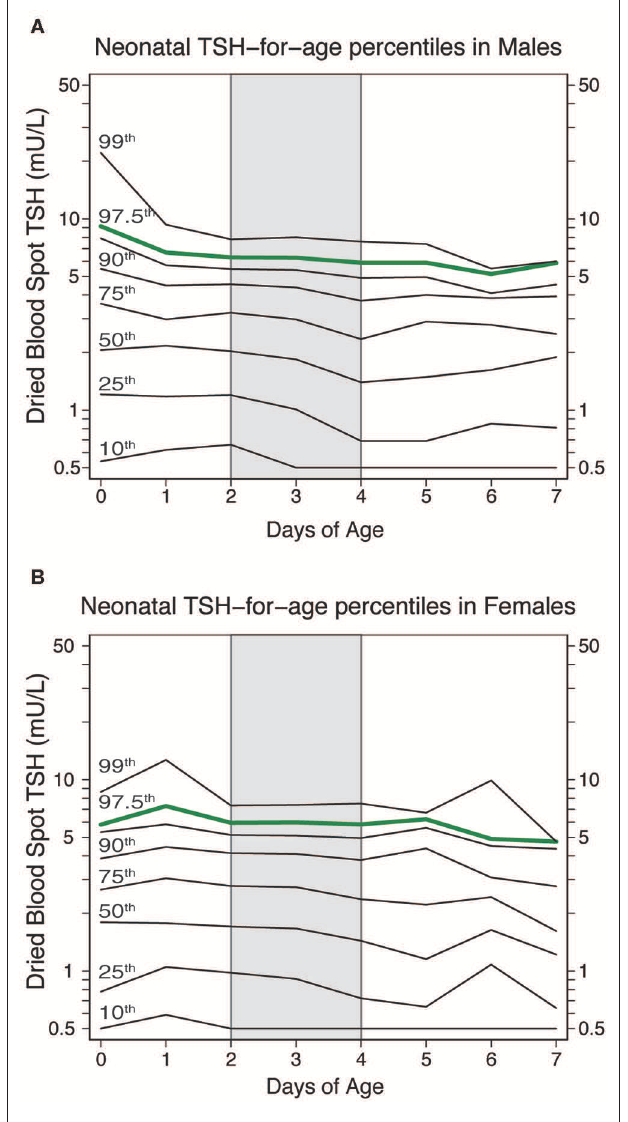
FIGURE 4 | Neonatal TSH percentiles charts in healthy neonates according to their neonatal age and sex [(males in panel (A) and females in panel (B) ]. The green line represents the 97.5th percentiles of neonatal TSH, which could be used to establish TSH cut-off value at the screening